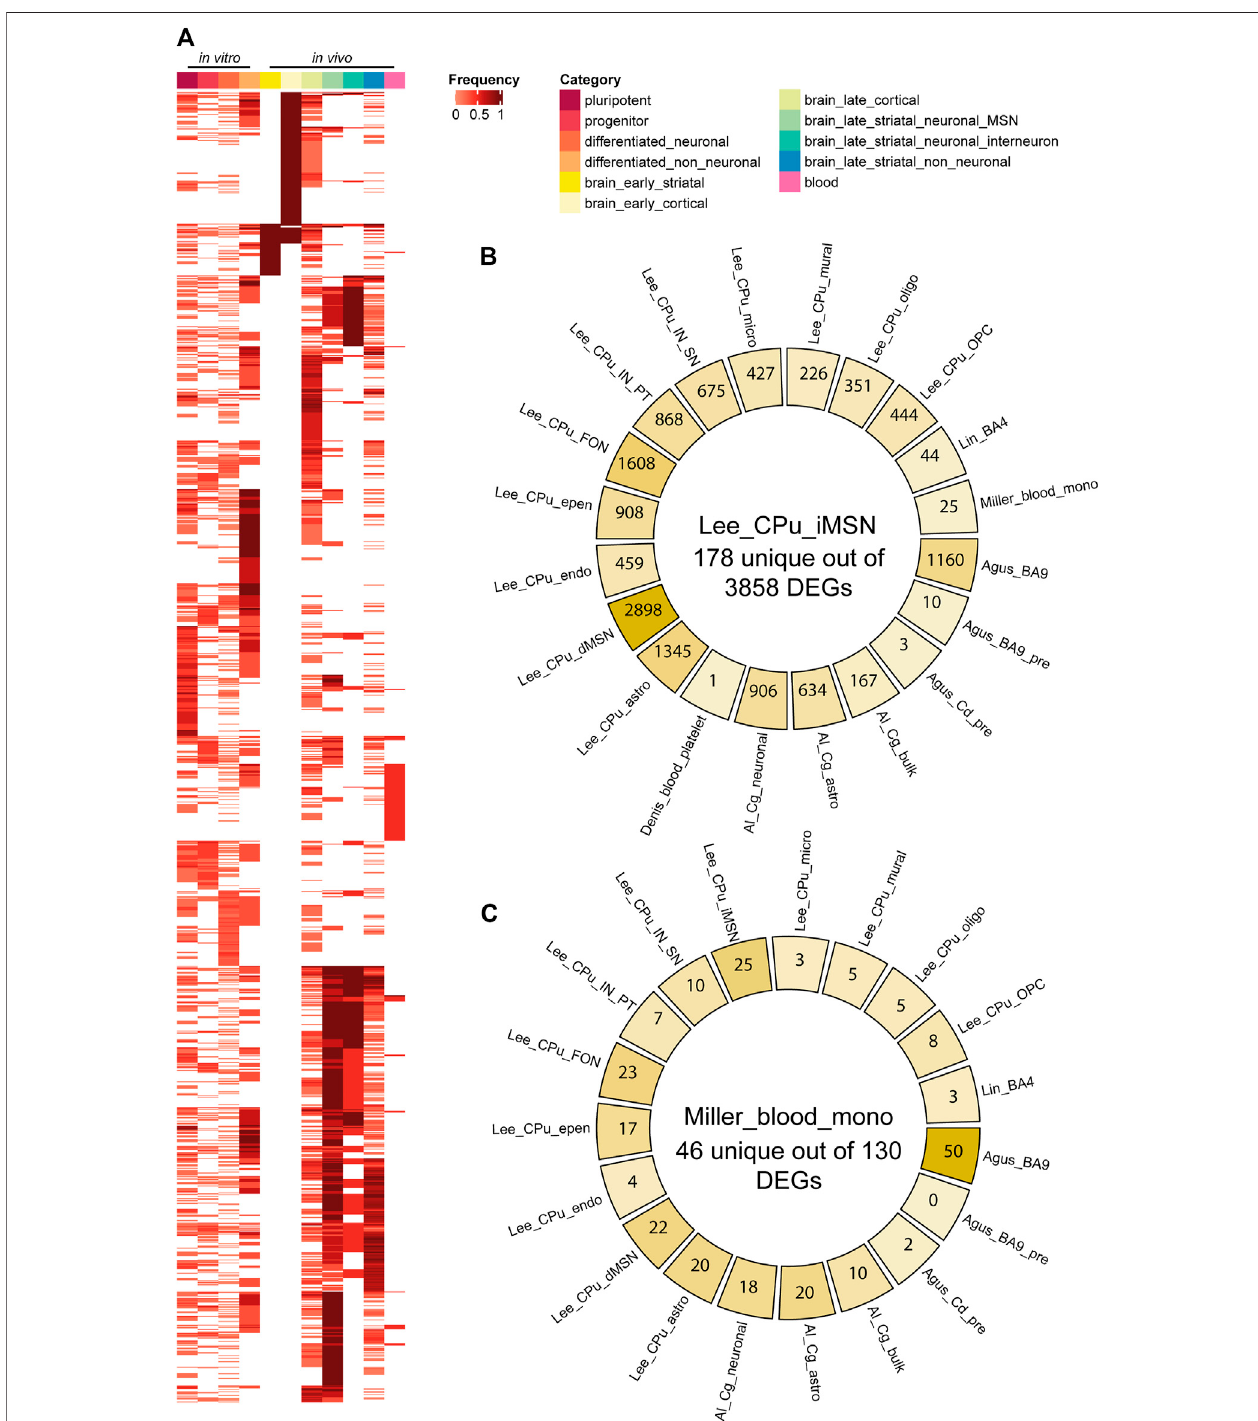
FIGURE 3 | HD differentially expressed gene (DEG) comparisons between categories and datasets. (A) DEG Frequency heatmap across all subcategories. Each column isasubcategory, each row is aDEG. DEG frequencyis calculated asthe number ofdatasets thatDEG appears in divided bythe total number ofdatasets in that subcategory. (B,C) Diagrams for pairwise comparisons of indirect pathway medium spiny neuron (iMSN) or blood monocyte DEG list vs all other data from primary tissues/cells. At the center is the number of unique DEGs in iMSN or blood monocyte, and on the side is the number of DEGs in common with other datasets. Abbreviations: CPu, caudate putamen; astro, astrocyte; epen, ependymal; endo, endothelial; IN, interneuron; PT, Pvalb/Th-expressing; MSN, medium spiny neuron; MNS,MAP2+andNES/SOX2-;OPC,oligodendrocyteprogenitorcell;oligo,oligodendrocyte;micro,microglia;NSC,neuralstemcell;Cg,cingulatecortex;FON,Foxp2/ Olfm3-expressing neuron; SN, Sst/Npy-expressing; dSPN/iSPN, direct/indirect pathway spiny projection neuron; mono, monocyte; NPC, neural progenitor cell; CoNeuron, cortical neuron; Cd, caudate nucleus; pre, presymptomatic; GPC, glial progenitor cell; APC, astrocyte precursor cell; BBB, blood brain barrier.